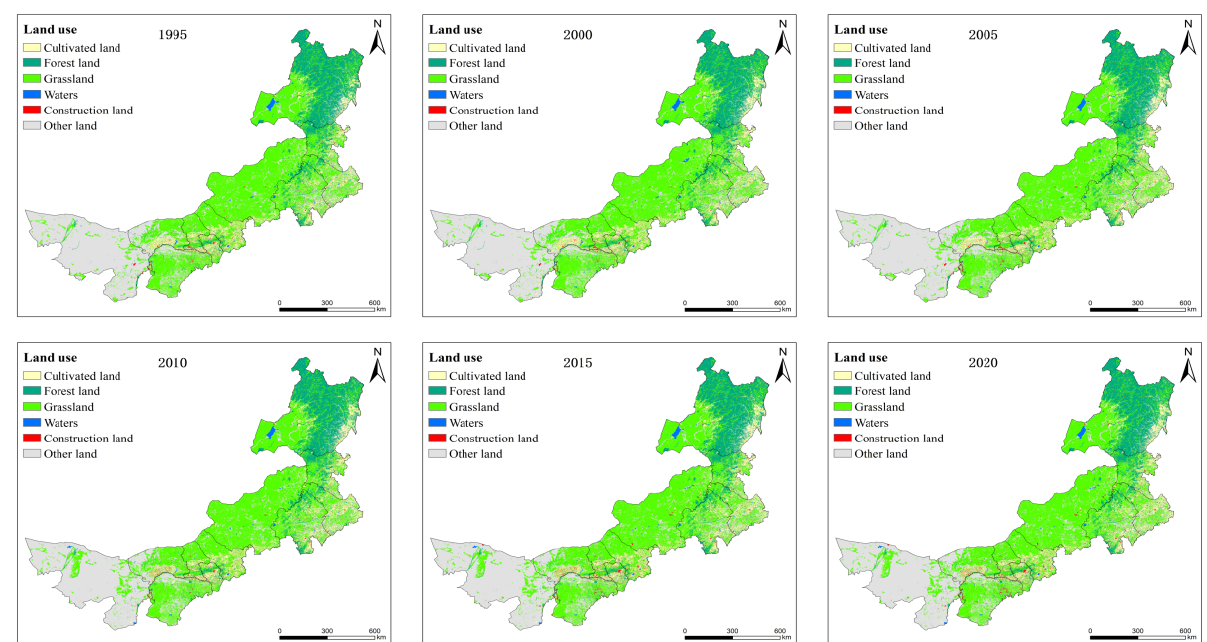
Figure 2. Land use types in Inner Mongolia from 1995 to 2020.